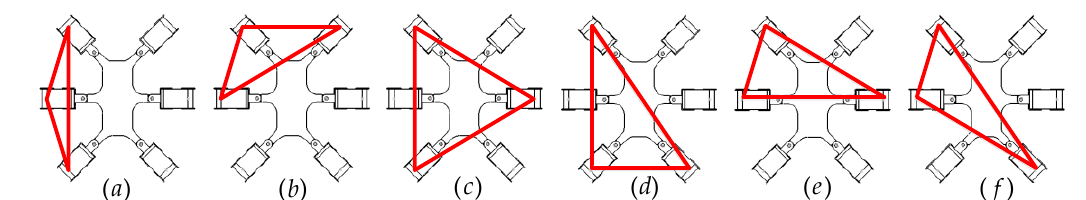
Figure 3. Six kinds of support triangles. (a) The triangle formed by legs on one side, (b) The triangle formed by two front legs and a middle leg, (c) The triangle formed by the front and rear leg on one side and the middle leg on the other side, (d) The triangle formed by two rear legs and a front leg, (e) The triangle formed by two middle legs and a front leg, (f) The triangle formed by the front and middle leg on one side and the rear leg on the other side.